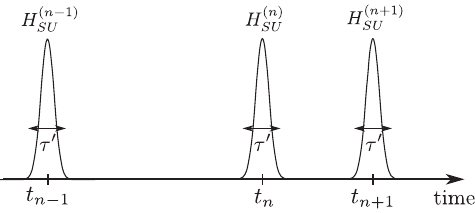
FIG. 5. Sketch of the Poisson-distributed regime: The system evolves freely most of the time but, once in a while, undergoes a ∼ τ 0 − 1 ) interaction with a unit short ( τ 0 → 0 ) and strong ( H SU where τ 0 denotes the duration of the interaction as in Sec. III. The duration τ between successive system-unit interactions fluctuates according to an exponential time distribution with average duration γ − 1